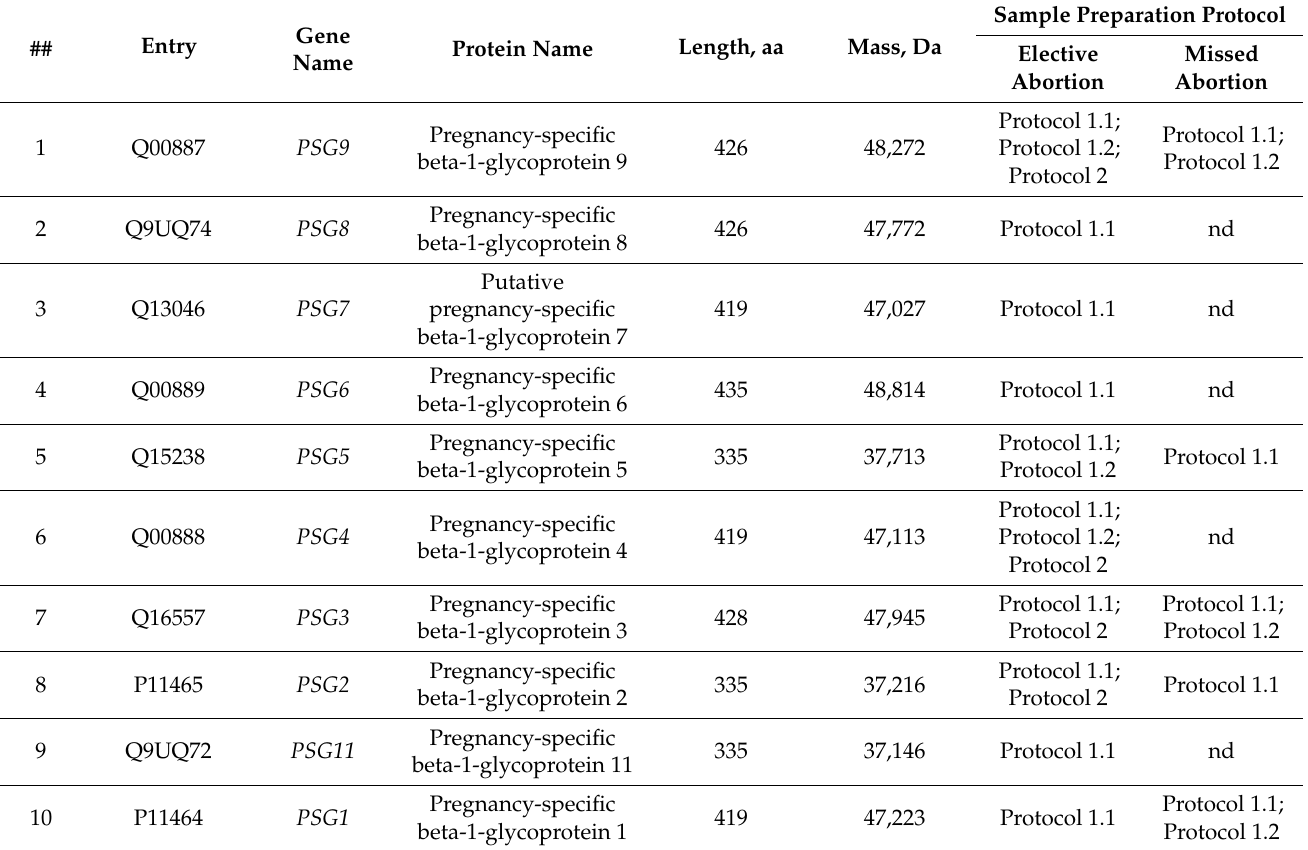
Table 4. The list of pregnancy-specific glycoproteins (PSGs) identified in human chorionic